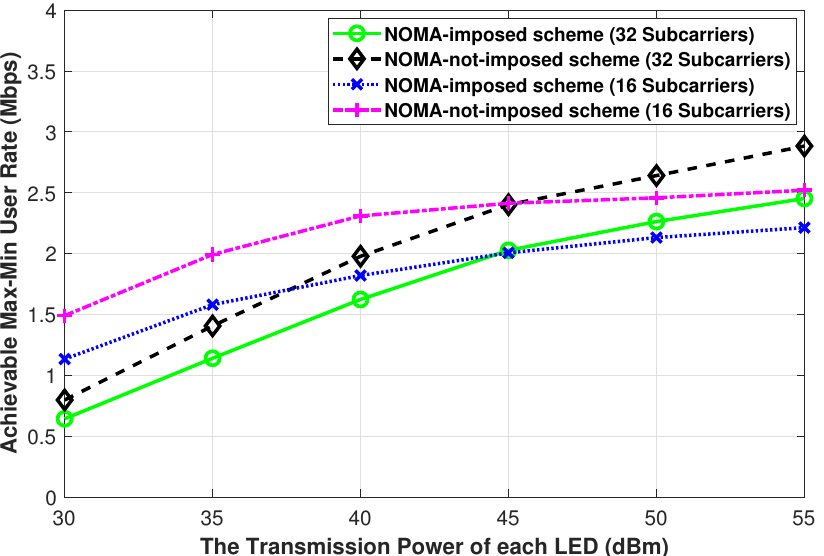
Figure 9. The achievable max-min user rate of the NOMA-imposed scheme and the NOMA-not- imposed scheme obtained while changing the LEDs’ electrical signal power. ( L = 4, N = 20, φ 1/2 = 60 ◦ , Ψ 1/2 = 85 ◦ ).